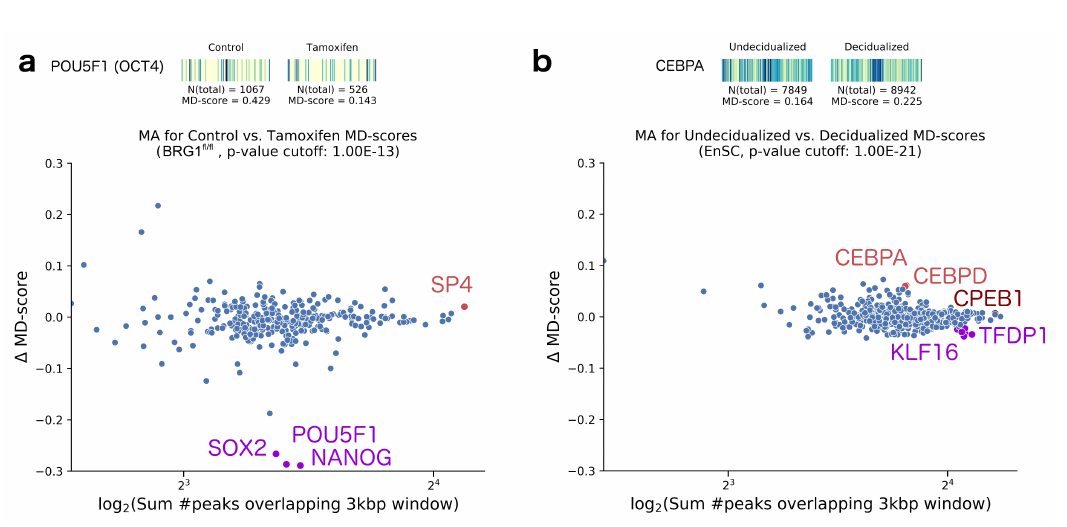
Figure 3. ( a ) Top: Motif displacement distribution as heatmap (increasingly dark blue indicates more instances of motif), MD-score and the number of motifs within 1.5 kb of an ATAC-seq peak before and after stimulation with Tamoxifen [62] for the inhibited TF POU5F1, also known as OCT4. We observe that the decreased MD-score reflects not only a smaller number of peaks nearby this motif, but also a sharp decrease in co-localization with the motif. Bottom: For all motif models (each dot), the change in MD-score following perturbation (y-axis) relative to the number of motifs within 1.5 kb of any ATAC-seq peak center (x-axis). Red points indicate significantly increased MD-scores ( p -value < 10 − 13 ). Purple dots indicate significantly decreased MD-scores, at the same indicated p -value. ( b ) Equivalent analysis performed on endometrial stromal cells, before and after undergoing a decidualization process [63]. The motif displacement heatmap illustrates ATAC-seq peak distances to CEBPA, the TF expected to be